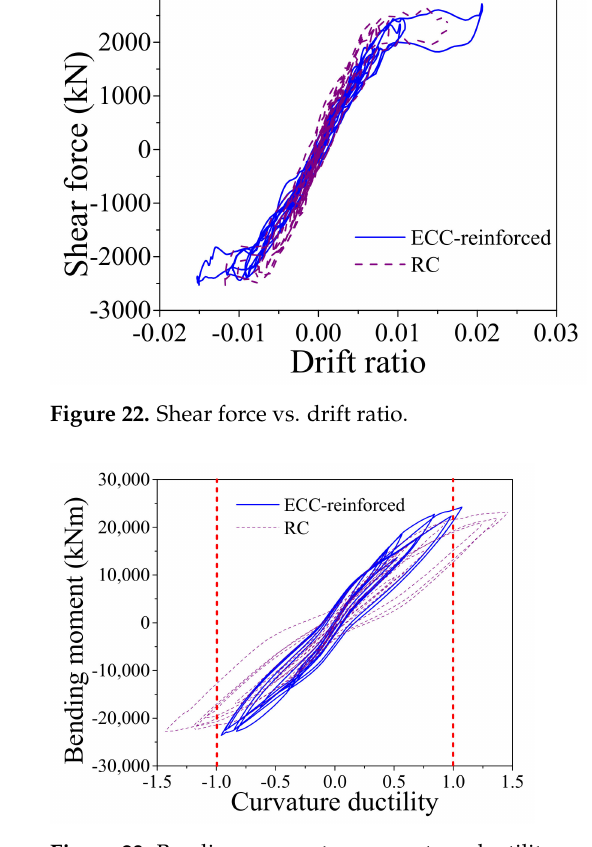
Figure 23. Bending moment vs. curvature